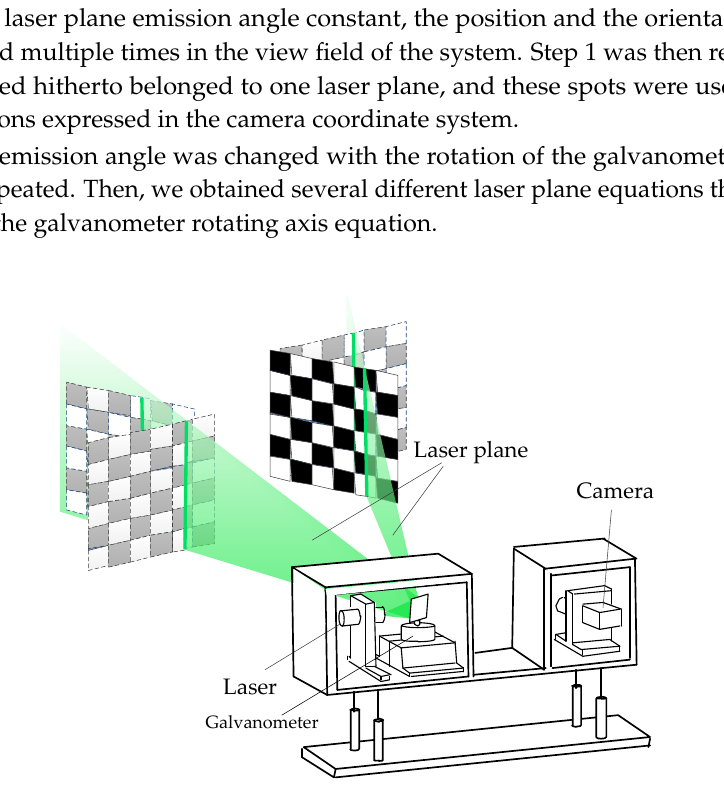
Figure 3. The schematic for the target location planning when performing the system calibration.